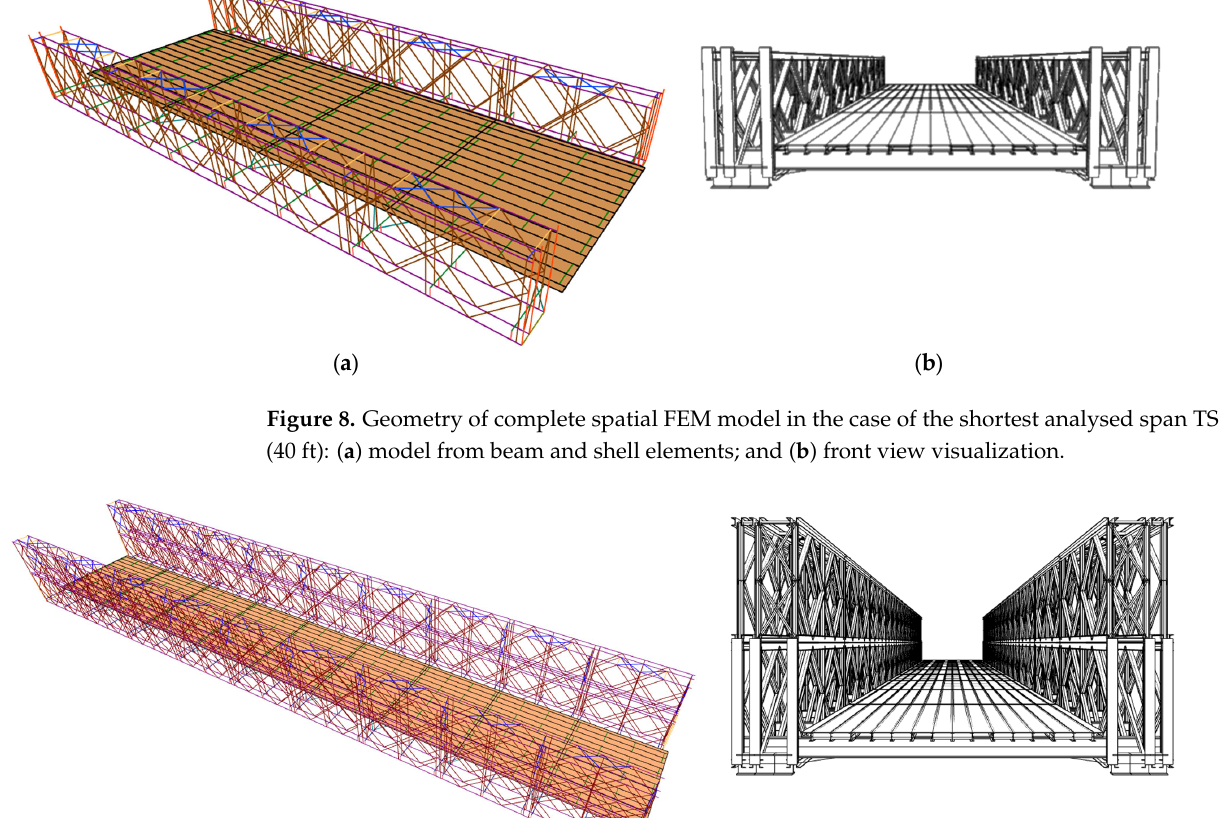
Figure 8. Geometry of complete spatial FEM model in the case of the shortest analysed span TS ‐ 12 (40 ft): ( a ) model from beam and shell elements; and ( b ) front view visualization.